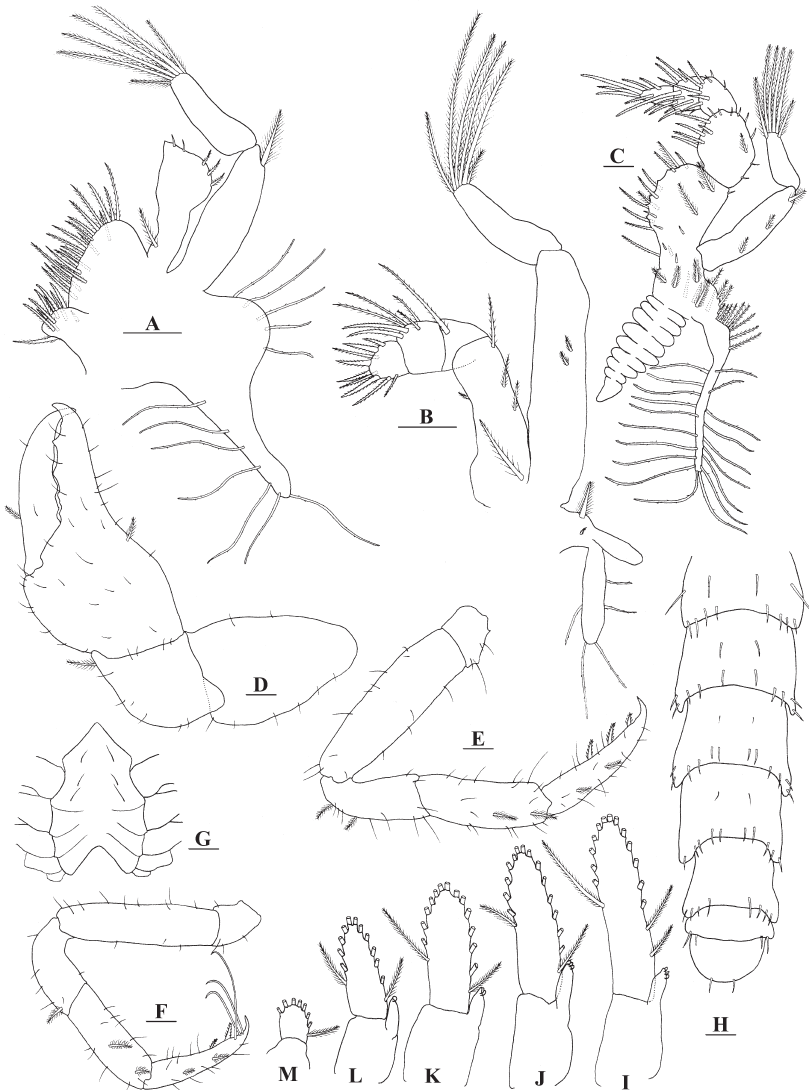
Fig. 8. – Pilumnoides hassleri . megalopa. A, first maxilliped; B, second maxilliped; C, third maxilliped; d, first pereiopod; e, second pereio- pod; F, fifth pereiopod; G, sternum, h, abdomen; i, first pleopod; J, second pleopod; k, third pleopod; L, fourth pleopod; m, uropod. scale bars. A-m, 0.1